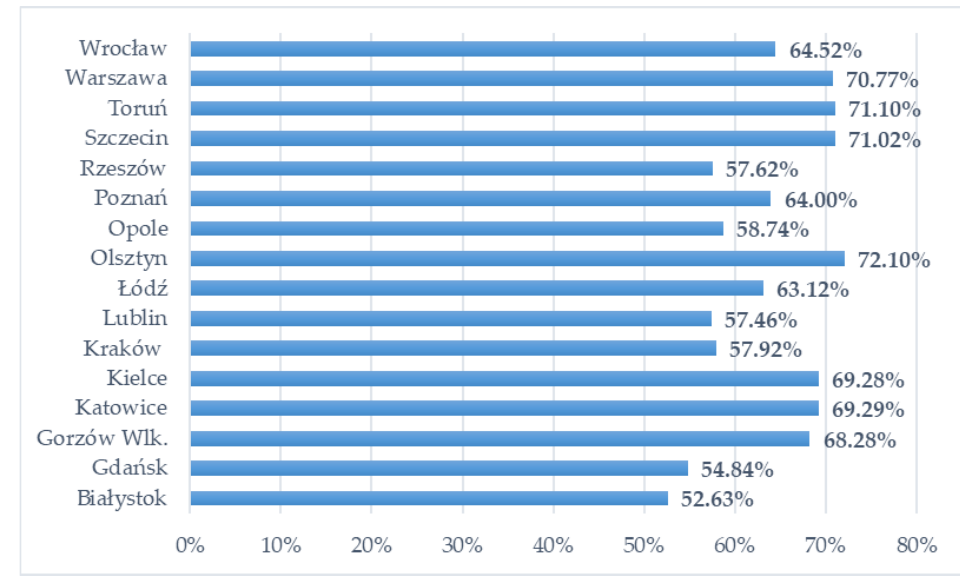
Figure 2. Share of mixed waste in total waste per capita from 2019 – 2021 [in %] in the analyzed